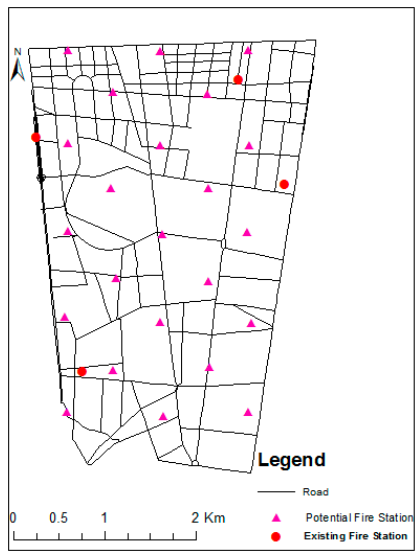
Figure 3. Potential and existing fire station locations.